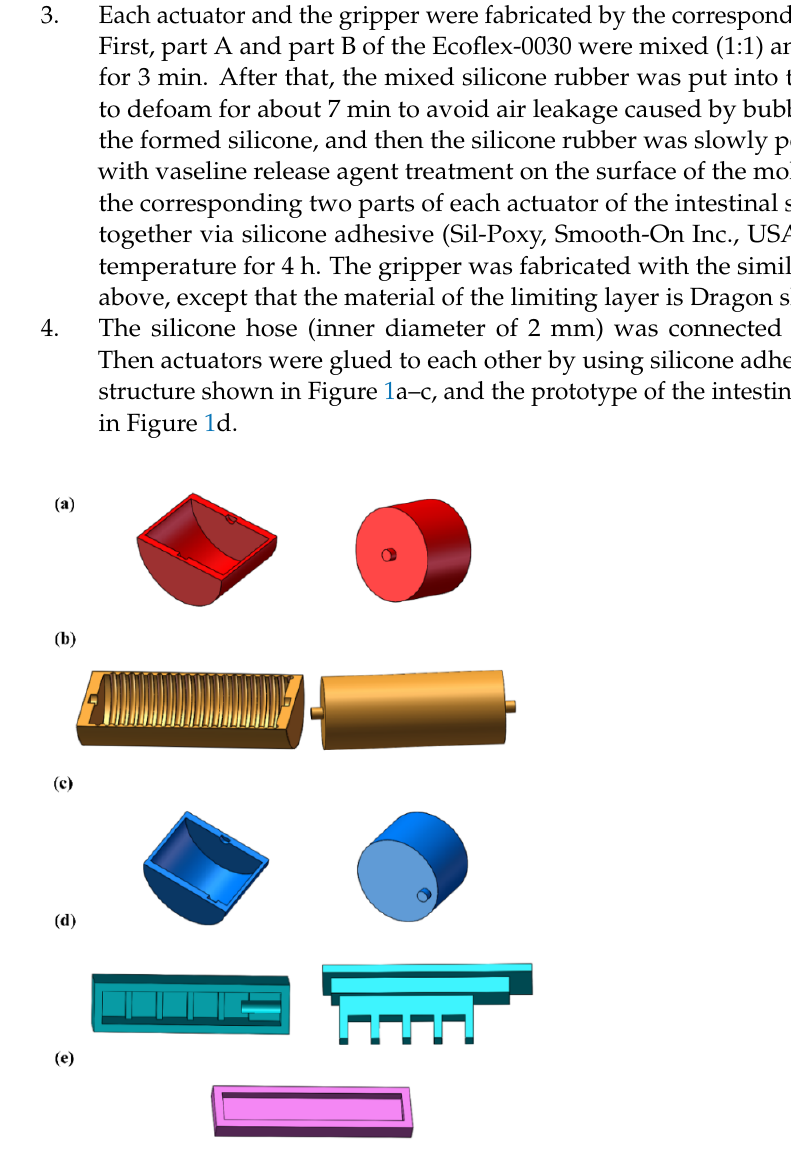
Figure 2. Molds for fabrication of the intestinal soft robot. ( a – c ) Molds to fabricate the frontal radial actuator, central axial actuator and rear radial actuator, respectively. ( d , e ) Molds to fabricate the strain layer and the limiting layer of the gripper, respectively.